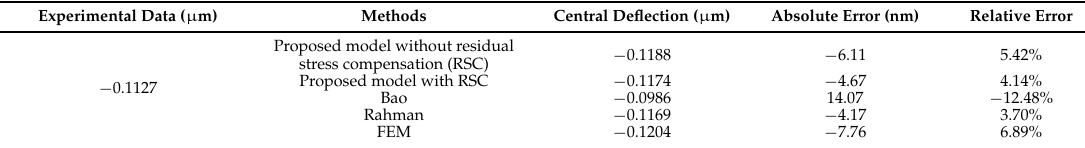
Figure 8. Static deflection profiles and their details of the double-layer CMUT membrane for 0.1 MPa, plotted from center to membrane edge. Table 5. Static deflection error analyses of the double-layer CMUT membrane for 0.1 MPa.